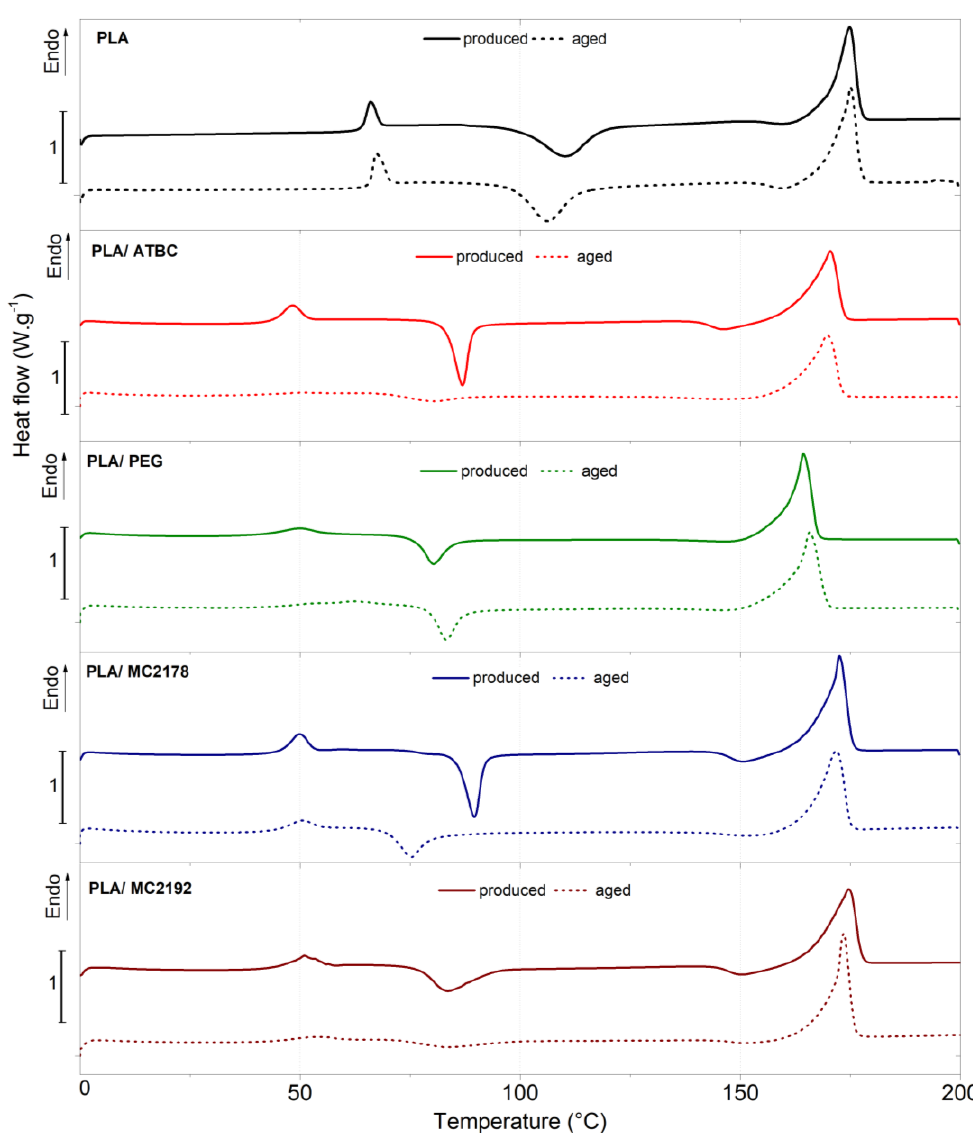
Figure 4. DSC curves of neat and plasticized PLA films after production and accelerated ageing.